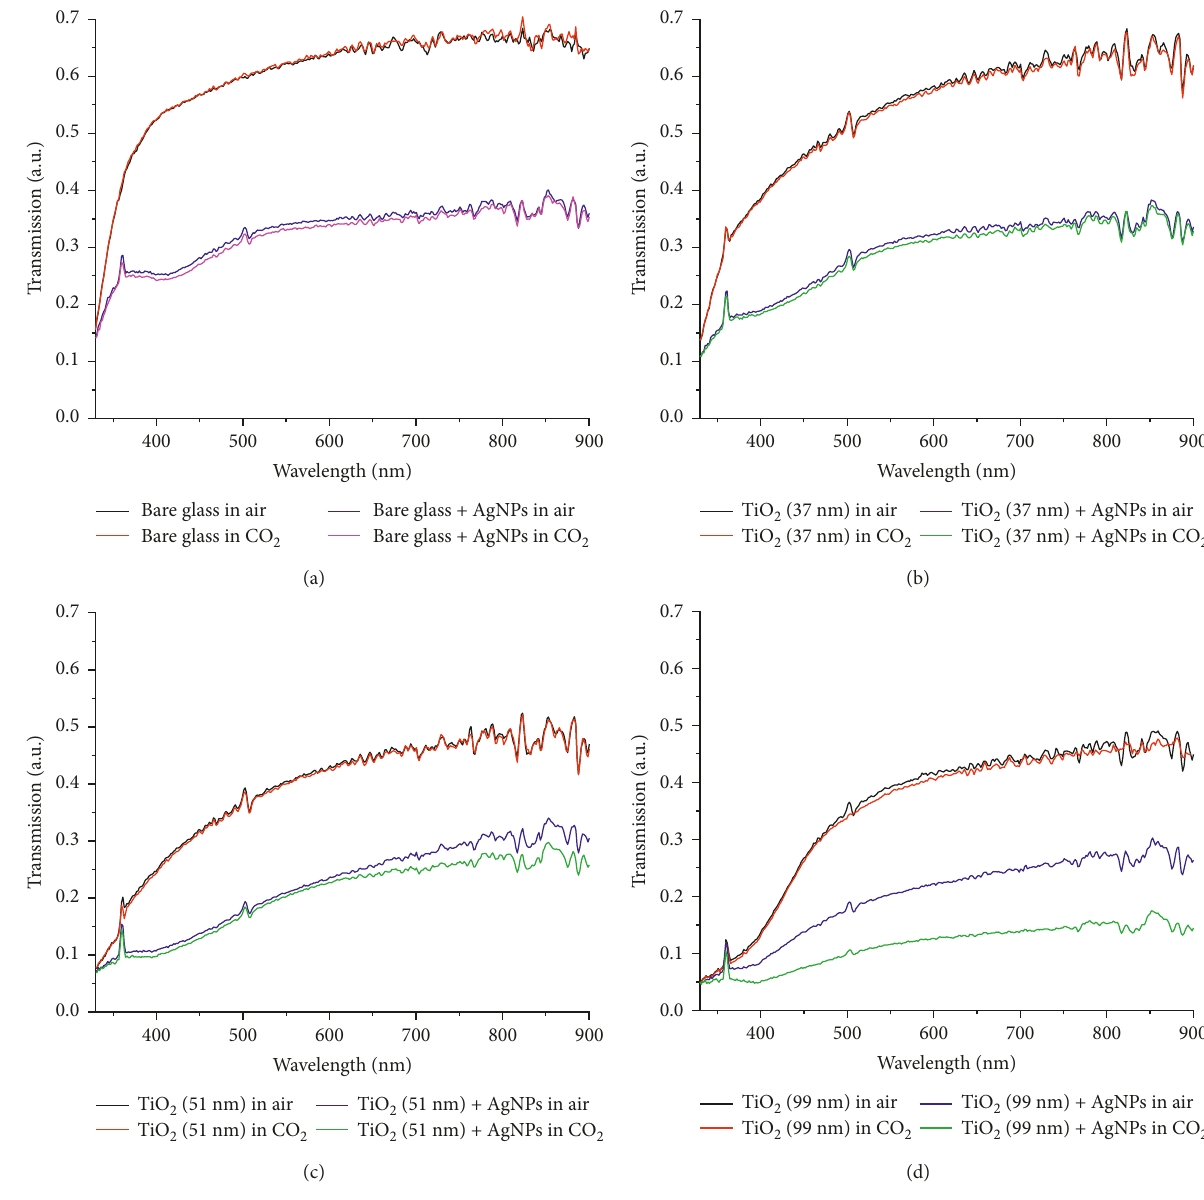
Figure 10: Comparison of optical responses of all samples in air and CO